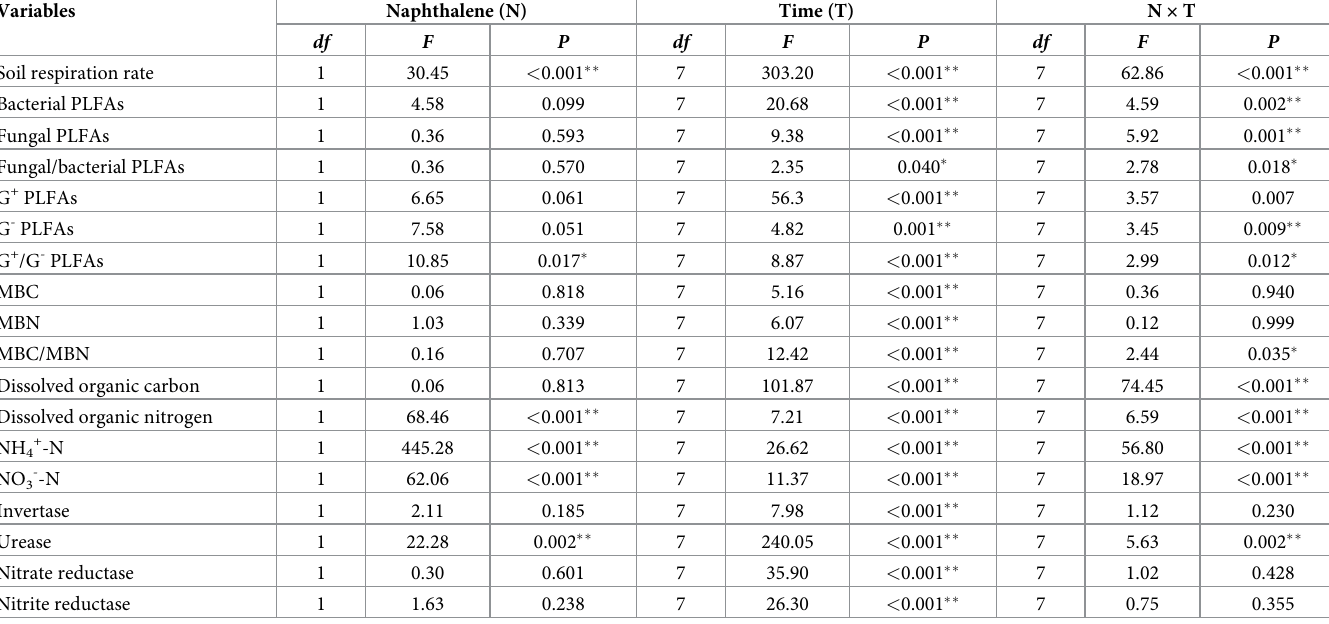
Table 1. Repeated measures ANOVA results of the responses of the soil respiration rate, microbial phospholipid fatty acid (PLFA) abundance, microbial biomass, nutrient content and enzyme activities to naphthalene application and sampling time.